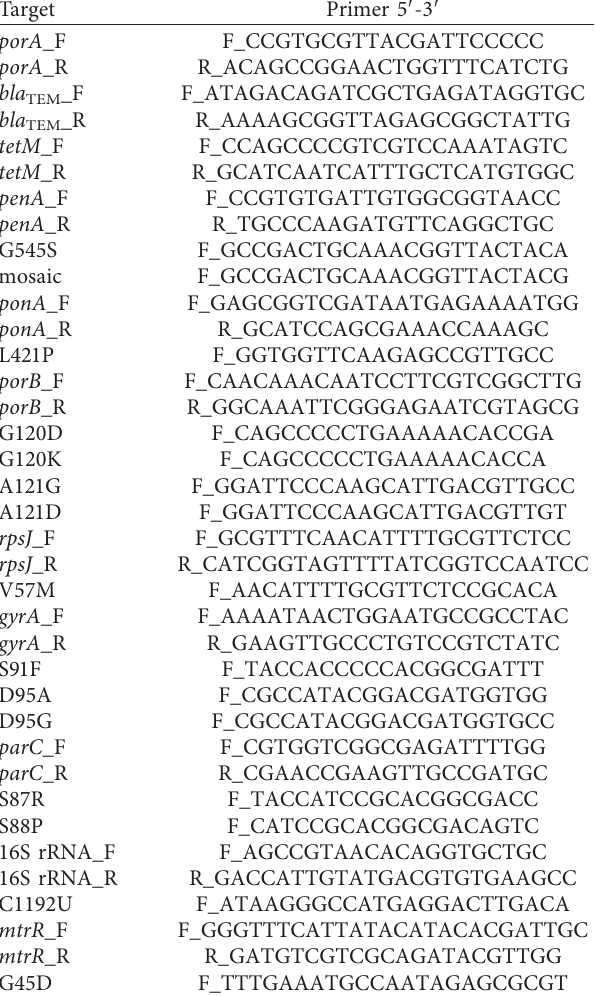
Table 1: Oligonucleotides used in this